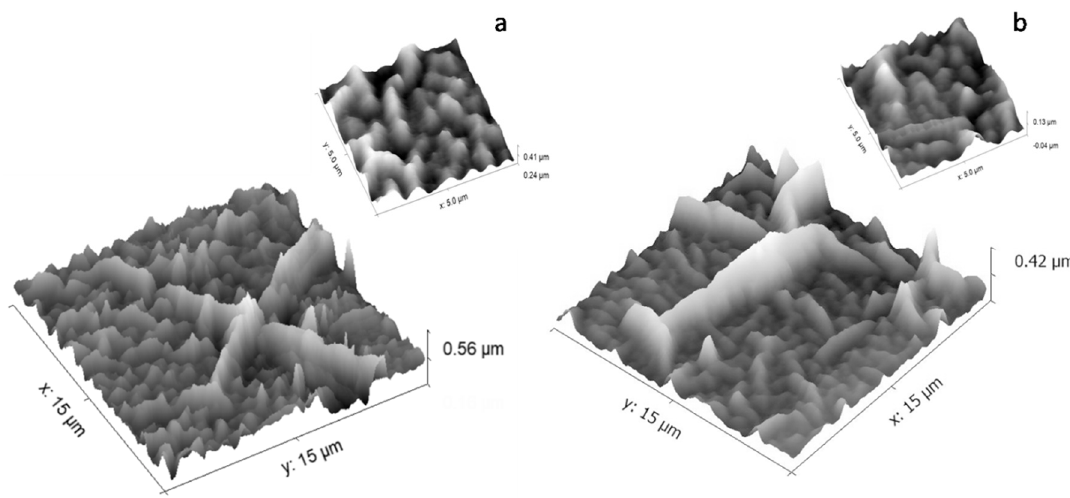
Figure 11. The calcium phosphate layers deposited on Ti substrate at: ( a ) 1.2 × 10 − 2 mbarr; and ( b ) 4.6 × 10 − 3 mbarr; Ar gas working pressure. × 10 − 3 mbarr; Ar gas working pressure.